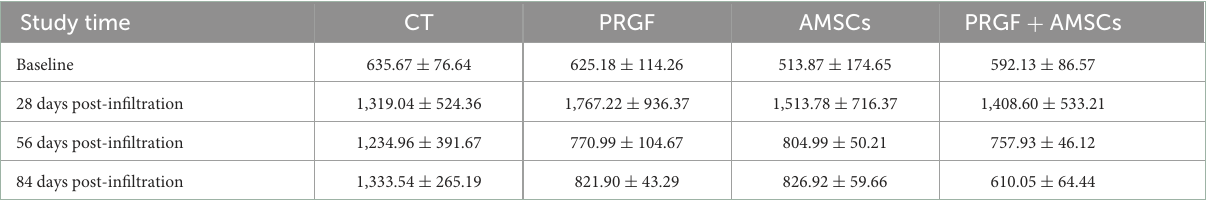
TABLE 2 Serum HA means standard deviation at different study times and treatment groups.